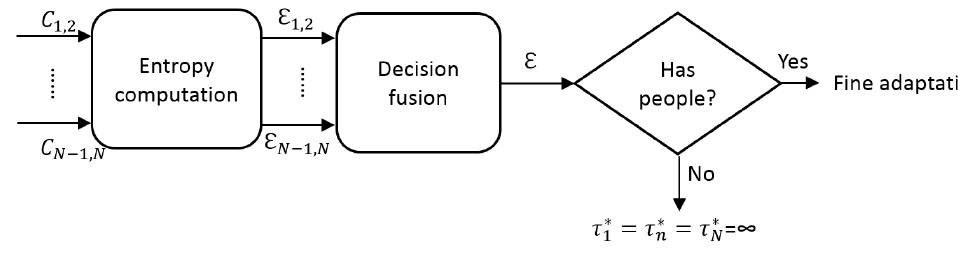
Figure 6. Overview of coarse